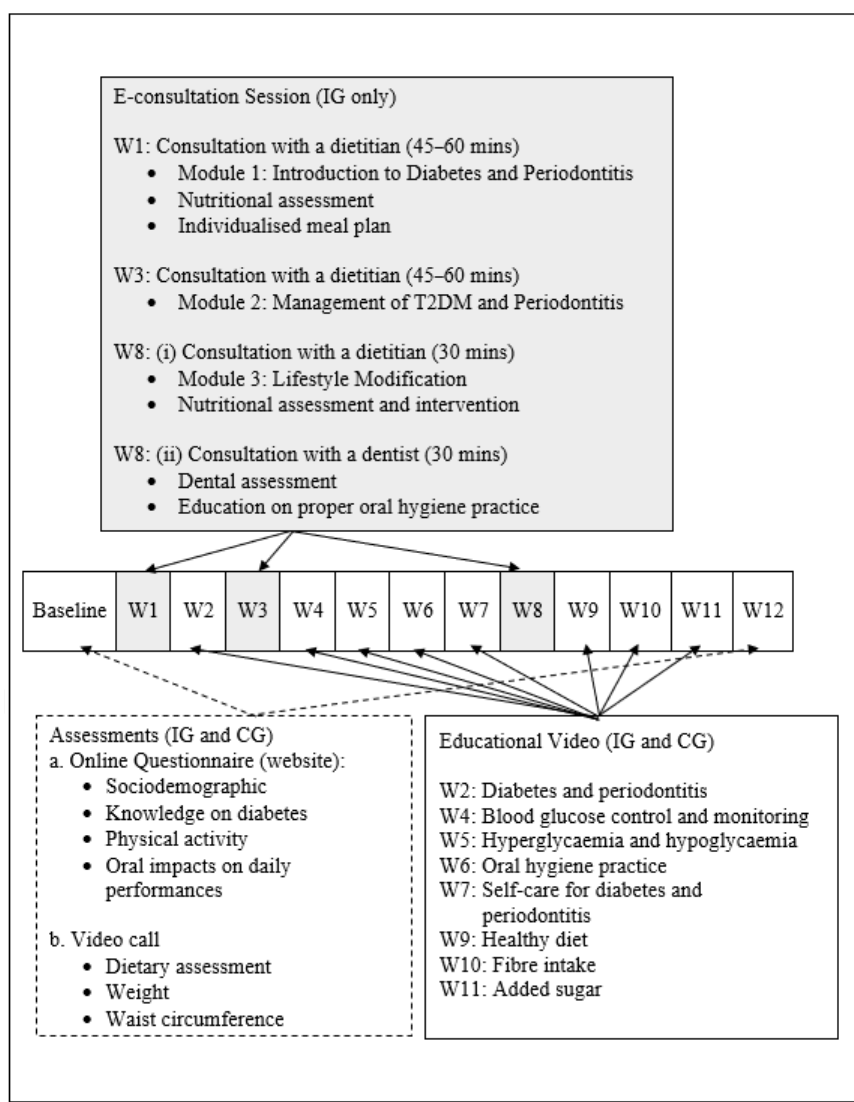
Figure 2. Diabetes Wellness Programme